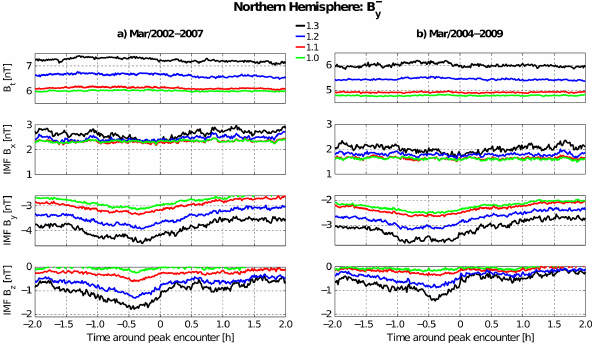
Fig. 7. The same as Fig. 5 but for the negative IMF B y component.